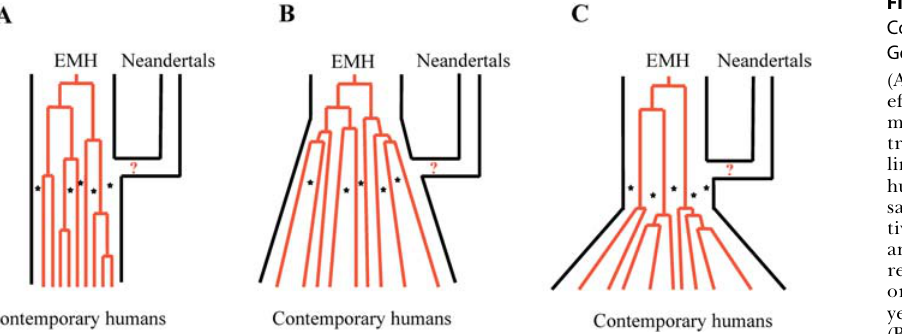
Figure 4. Schematic Model of Putative Contribution of Neandertal mtDNA to the Gene Pool of Modern